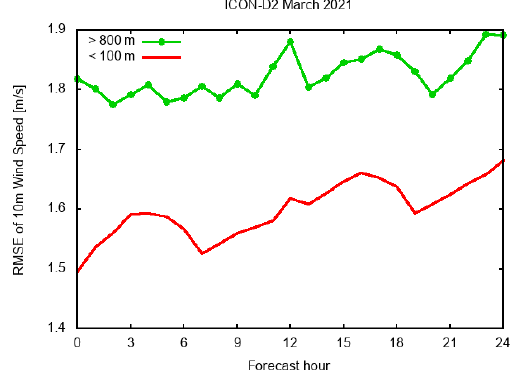
Figure 3. RMSE of 10m wind speed from the numerical weather prediction model ICON-D2 in March 2021 compared to observa- tions at sites below 100m (red) and above 800ma.s.l. (green). The ICON-D2 domain covers central Europe including most of France to Poland and from northern Italy to Denmark, and thus locations above 800m are typically in hilly or mountainous terrain. For de- tails of the ICON-D2 model, see Reinert et al.